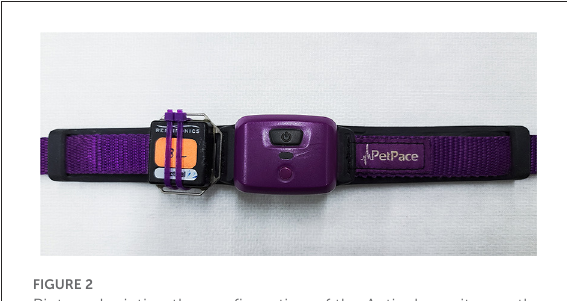
FIGURE2 Picture depicting the configuration of the Actical monitor on the PetPace collar used in this study. The Actical monitor was fixed to the PetPace collar using zip ties, which were then covered with VetWrap to prevent injury from the sharp ends of the zip